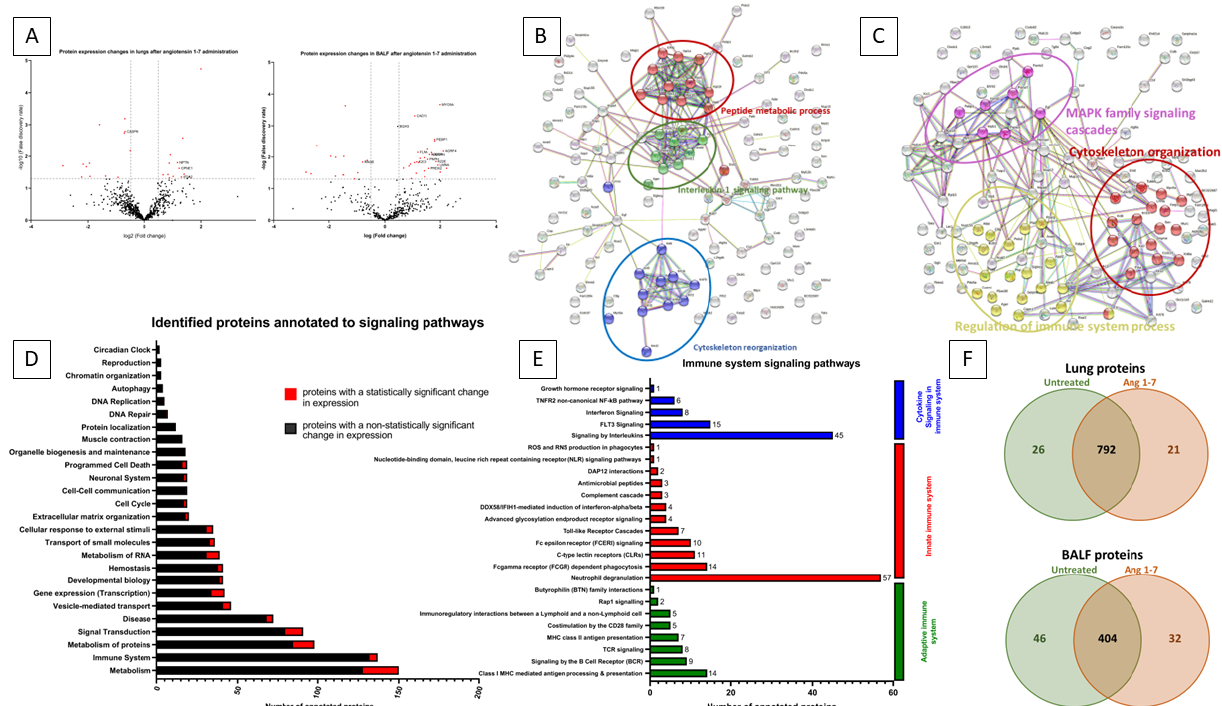
Figure 6. Proteome analysis of whole lung tissue lysate and bronchoalveolar lavage fluid. Panel ( A ): Volcano plot showing protein expression fold change values and their corresponding false discov- ery rate ( − log10 p -value). Red points show statistically significant proteins with FDA > 1.3. Volcano plot on the left represents the whole lung tissue lysate proteome after angiotensin (1–7) stimulation normalized to untreated group. Volcano plot on the right represents the bronchoalveolar lavage (BAL) fluid proteome after angiotensin (1–7) stimulation normalized to untreated group. Panel ( B ): Graph of mutual interactions between proteins drawn with the use of SPRING.org. Only proteins with altered expression in whole lung tissue lysate after stimulation of mice with angiotensin (1–7) were included in the analysis. The main biological processes by which the identified proteins are functionally related are marked with separate colors. With red color are labeled proteins involved in peptide metabolic process, with green color are labeled proteins involved in Interleukin-1 signaling pathway, with blue color are labeled proteins involved in cytoskeleton reorganization. Panel ( C ): Graph of mutual inter- actions between proteins drawn with the use of SPRING.org. Only proteins with altered expression identified in BALF after stimulation of mice with angiotensin (1–7) were included in the analysis. The main biological processes by which the identified proteins are functionally related are marked with separate colors. With red color are labeled proteins involved in cytoskeleton organization, with purple color are labeled proteins involved in MAPK family signaling cascades, with yellow color are labeled proteins involved in regulation of immune system processes. Panel ( D ): Graph represents the number of identified proteins in whole lung tissue lysate which were annotated to signaling pathways based on Reactome.org. With black color are labeled proteins which were not show altered expression after Ang (1–7) stimulation compared to untreated group. With red color are labeled protein with statistically significant change in expression after Ang (1–7) stimulation, when compared to untreated group. Panel ( E ): Annotation to detailed signaling pathways of immune system divided into Cytokine signaling in immune system labeled with blue color, Innate immune system labeled with red color, Adaptive immune system labeled with green color. Panel ( F ): Venn diagram that shows total number of identified proteins in whole lung tissue lysate (upper diagram) and BALF (lower diagram) from untreated and Ang (1–7)-treated